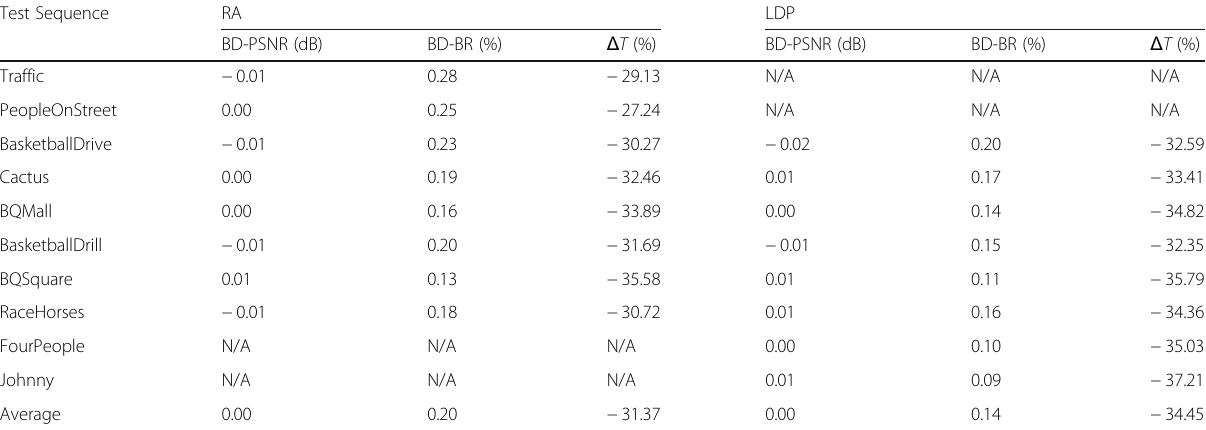
Table 10 Comparison between ADS + SRA and the original HM 14.0 Test